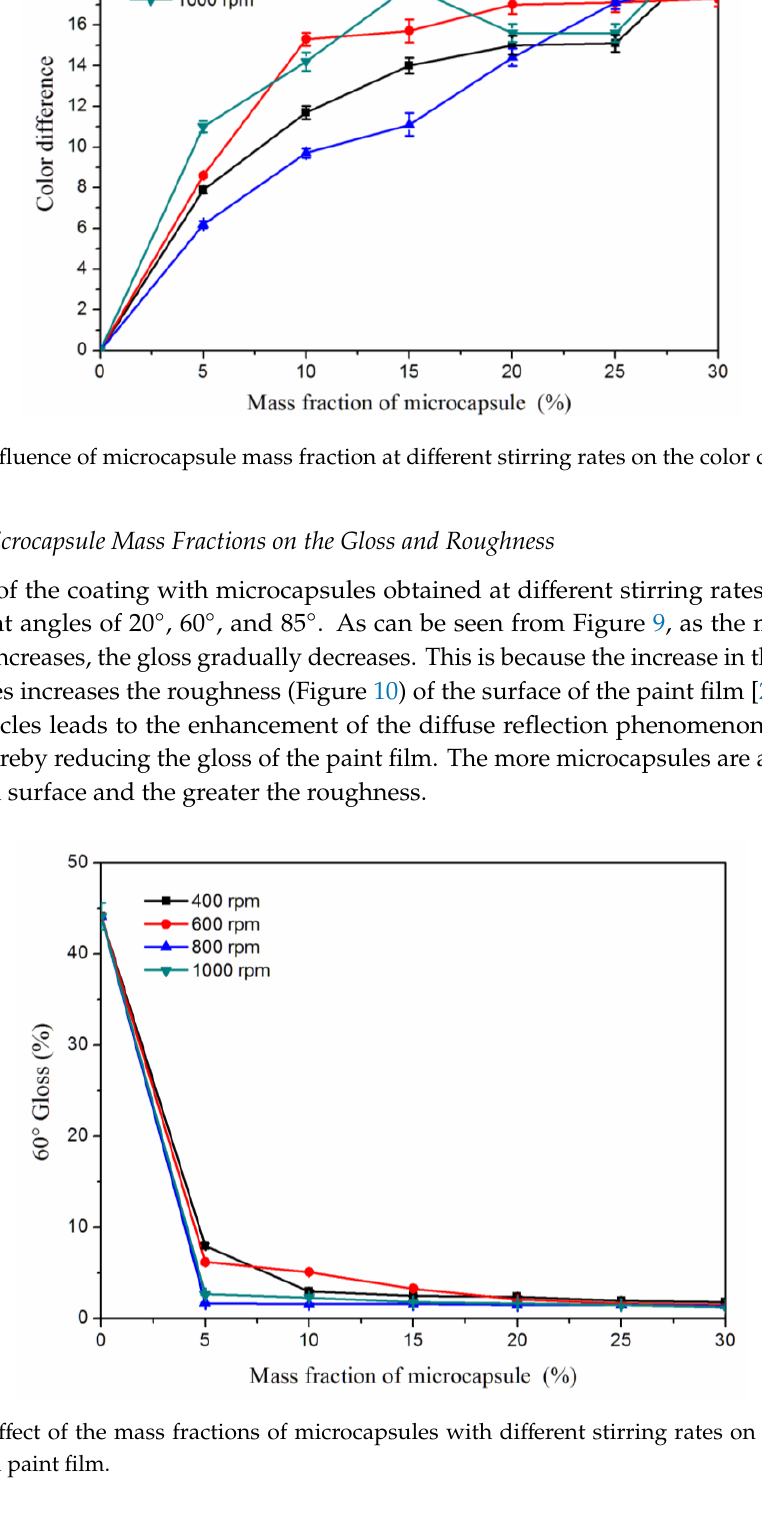
Figure 10. Effect of the mass fractions of microcapsules with different stirring rates on the roughness of water-based paint film.